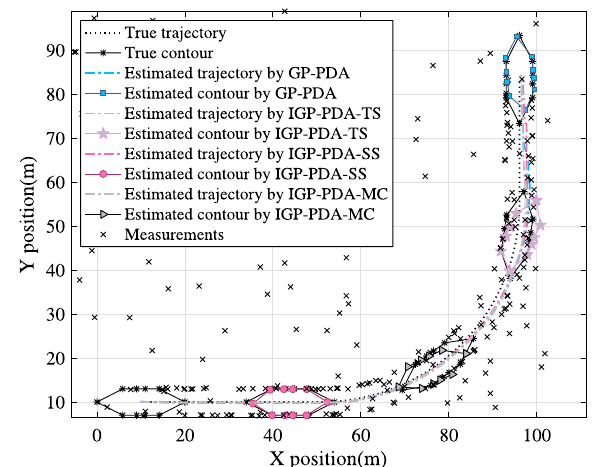
Fig. 8 True and estimates trajectories in the second scenario